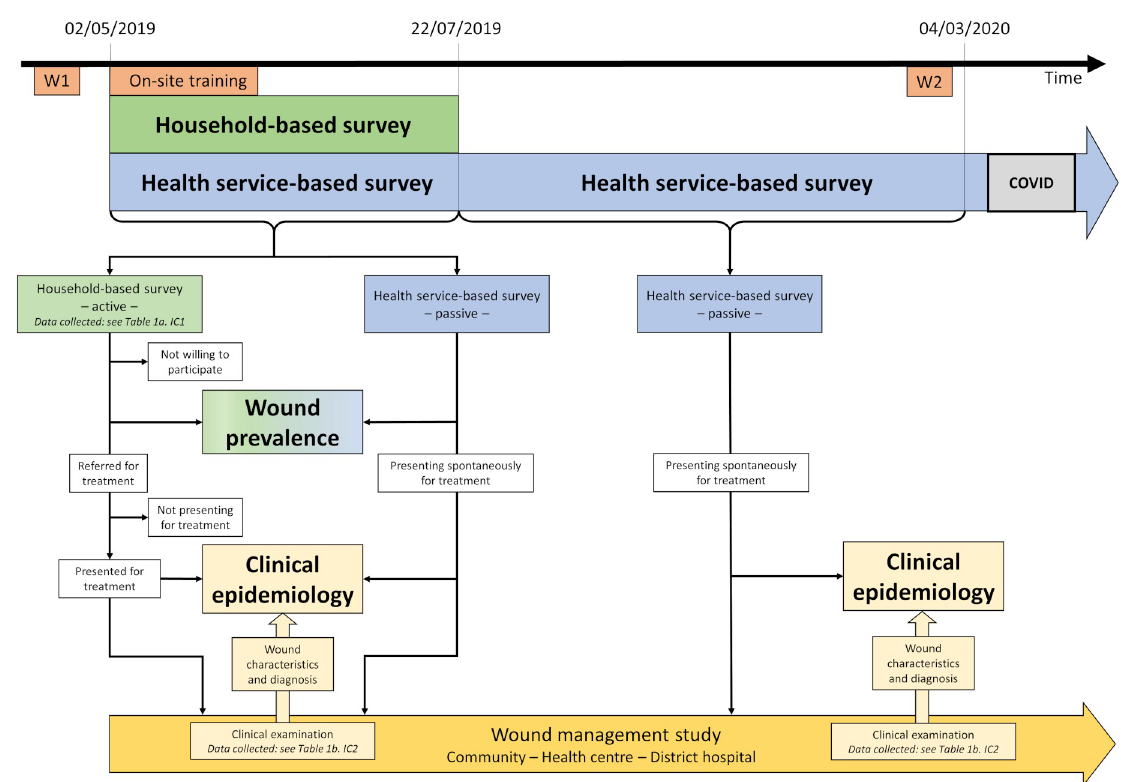
Fig 1. Study flow chart: interaction between household- and health services-based surveys and wound management study. Patients with wounds were actively (household-based survey) and passively (health services-based survey) identified in Ahondo Health Area which is part of the Taabo Health and Demographic Surveillance System (HDSS) to determine the wound prevalence and the clinical epidemiology of wounds in a rural setting of West Africa. This was combined with an observational wound management study at three health care levels–community, health centre and district hospital–aiming at early identification and treatment of wounds [18]. This approach secured appropriate treatment for all patients identified during the wound surveys. W1 and W2: Training workshops of nurses, assistant nurses, and community health workers (CHW). IC1 and IC2: Informed consent for cross-sectional study and wound management study